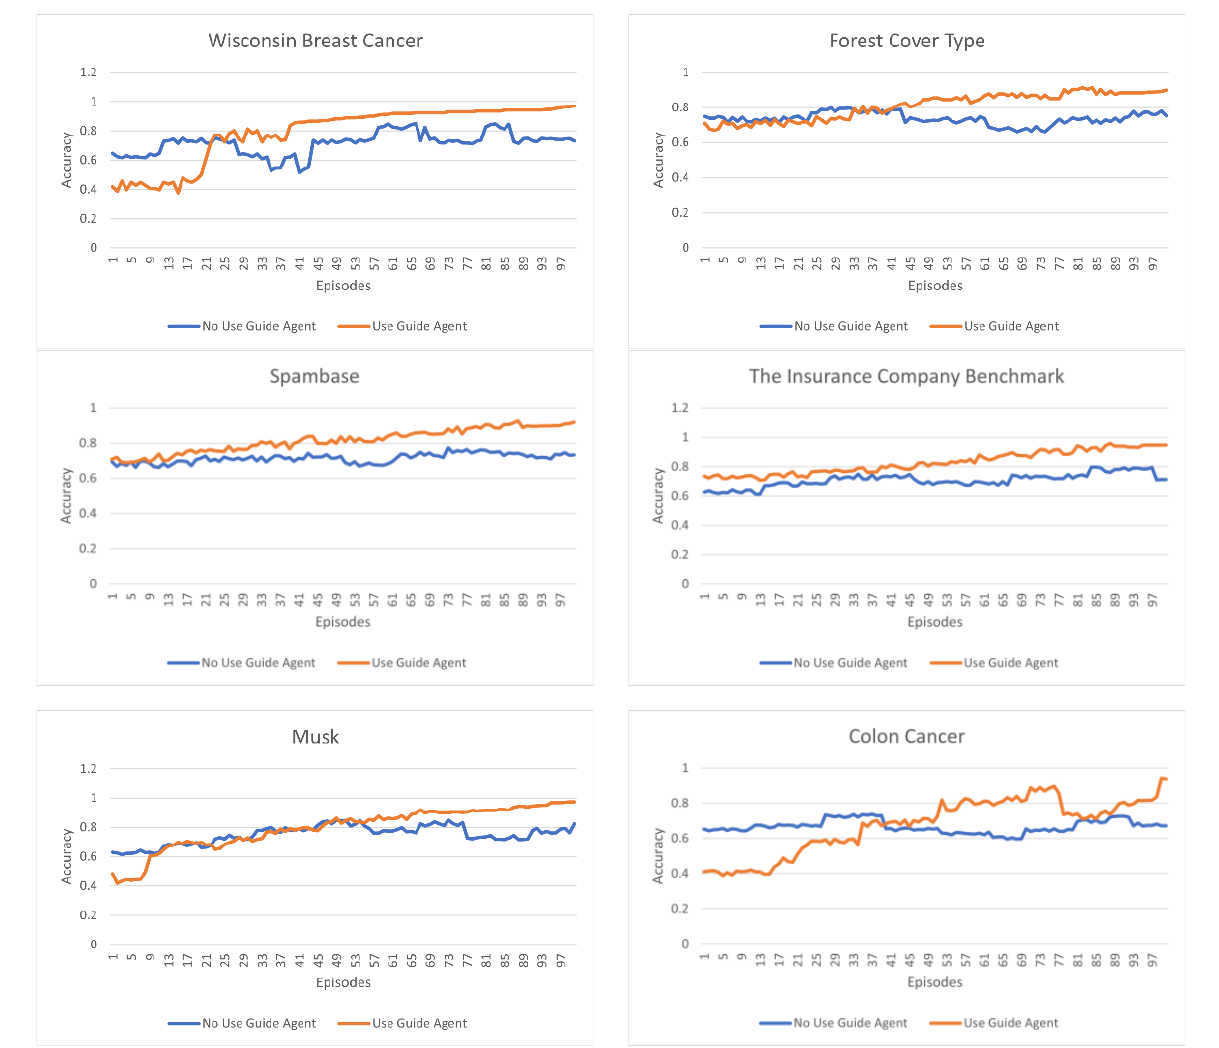
Figure 5. Number of selected features per episode, for each dataset.